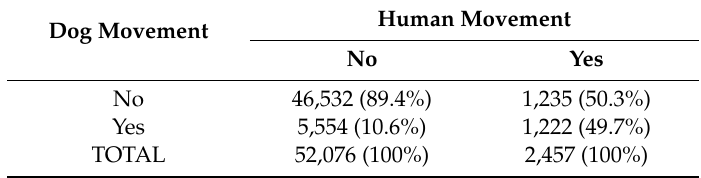
Table 1. Cross tabulation of simultaneous human and dog movement.